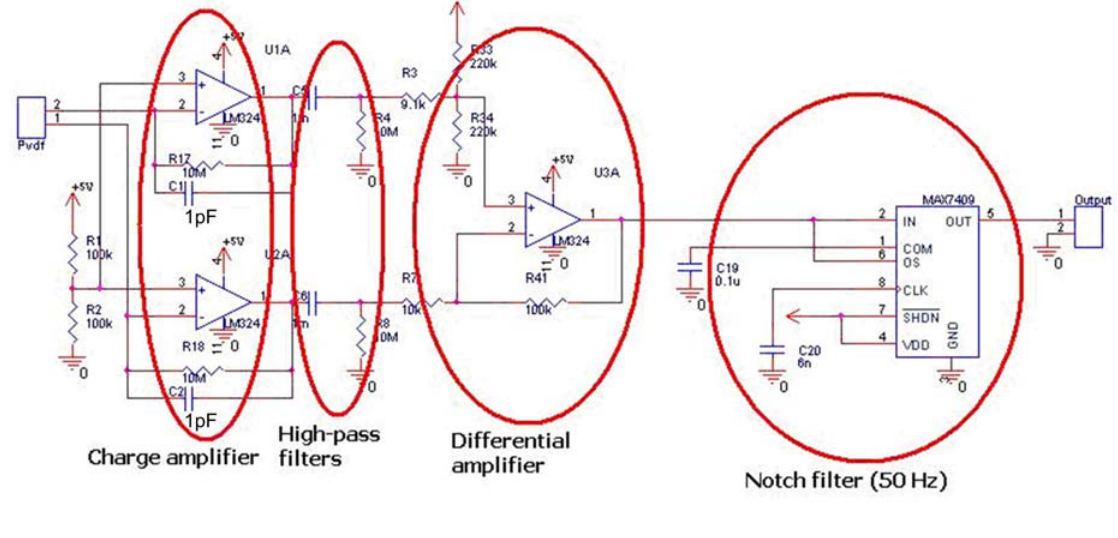
Figure 12. The electronic interface of the PVDF micro/nano fiber